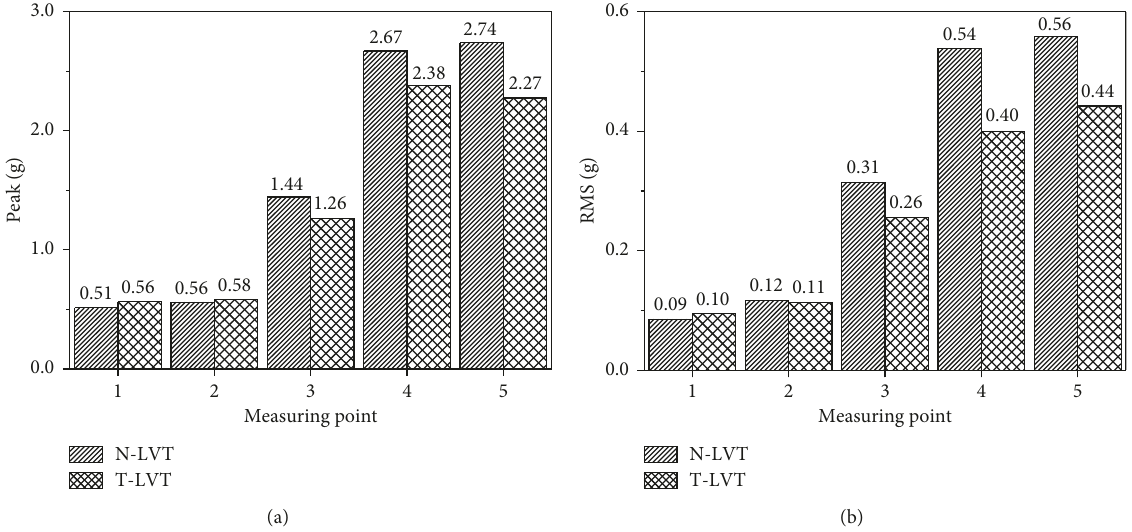
Figure 16: Track slab acceleration peak and RMS. (a) Acceleration peak. (b) Acceleration